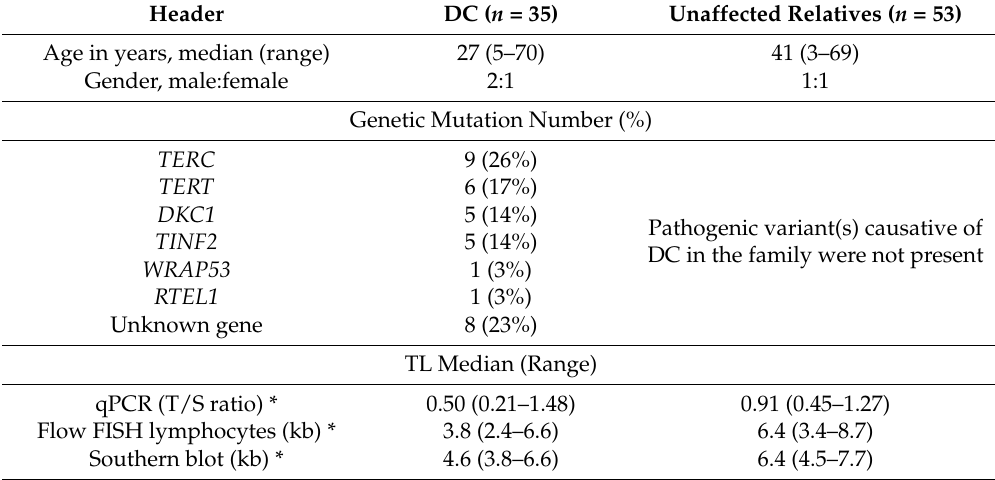
Table 1. Demography and comparison of telomere length (TL) by different methods.